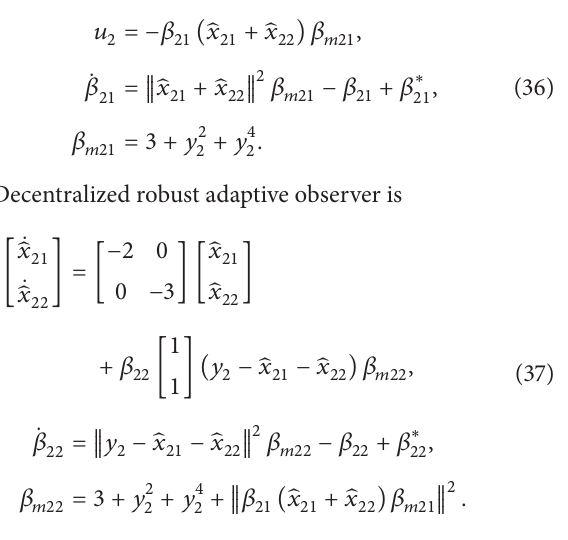
Decentralized robust adaptive controller